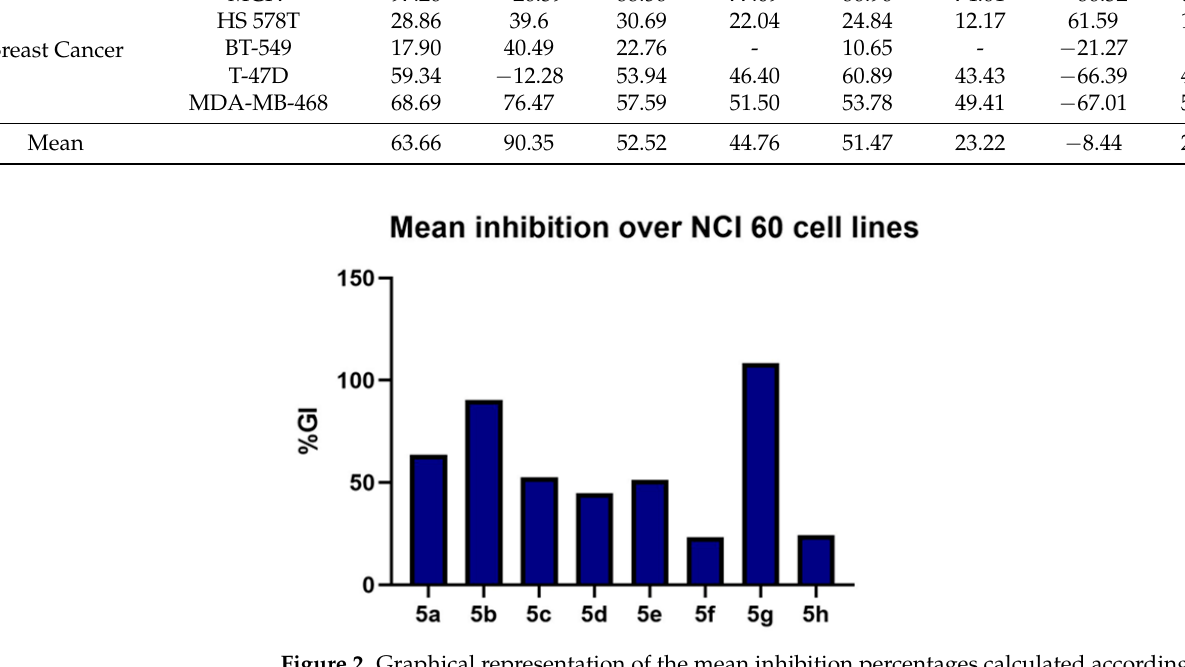
Table 2. In vitro cytotoxicity IC 50 ( µ M) results against acute myeloid leukemia cells HL-60 PBMC and selectivity index (SI) which was calculated as the ratio of cytotoxicity (IC 50 ) of PBMC to cancer cells